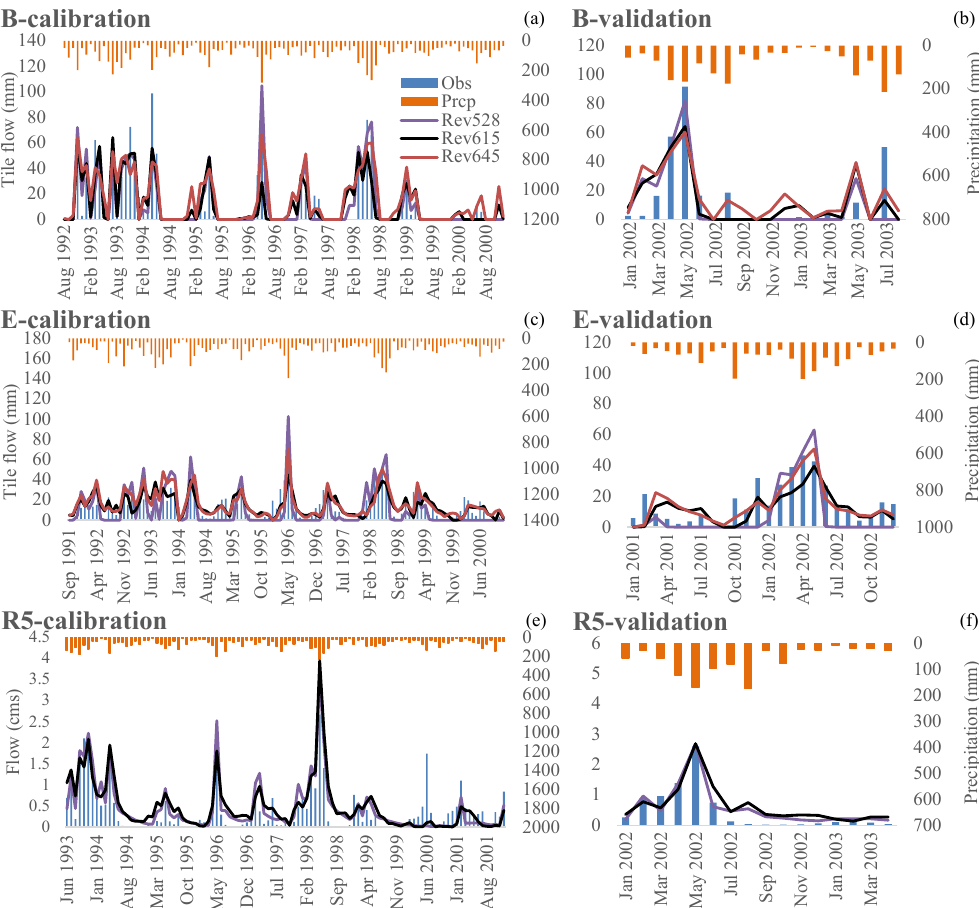
Figure 3. Calibration and validation results for monthly tile flow at sites B (a, b) and E (c, d) , and monthly flow at site R5 (e, f) . Obs, Prcp, and Revs. 528, 615, and 645 represent Observed, Precipitation, and revisions 528, 615, and 645,